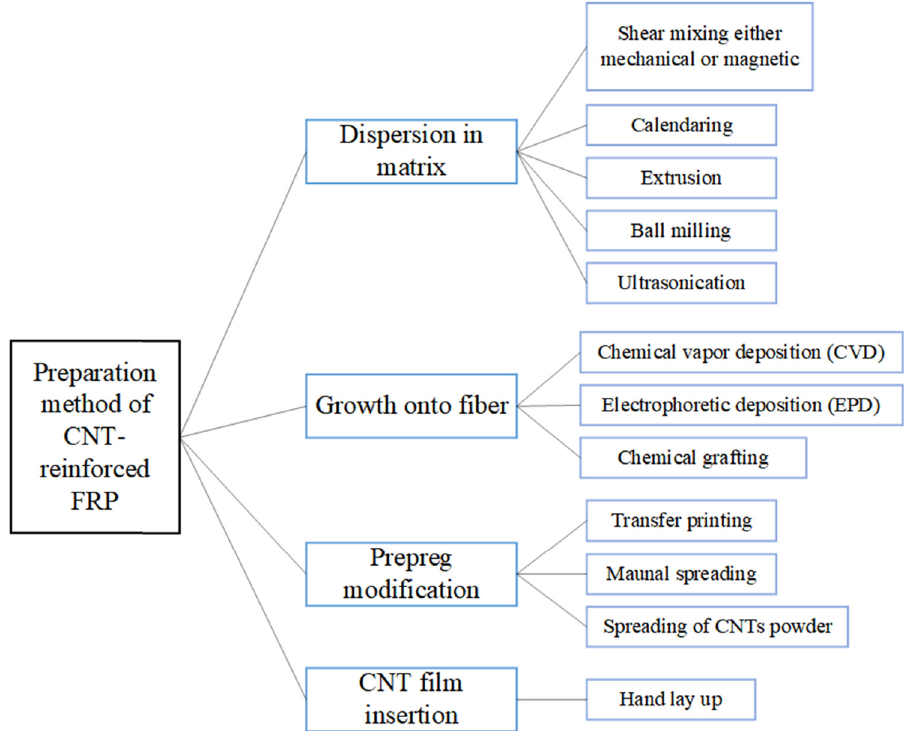
Figure 6: Di ff erent preparation methods of CNT - reinforced